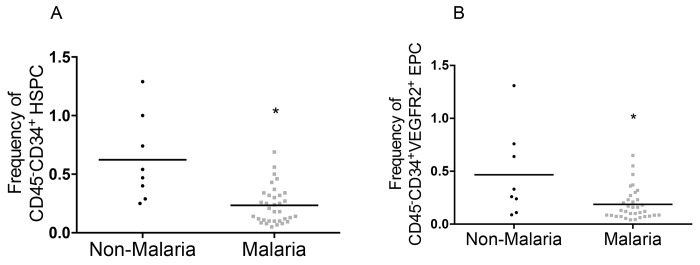
CD34+ cell populations decreased in malaria.(A) CD34+ hematopoietic stem and progenitor cell populations are significantly decreased in malaria patients. Median fluorescence intensity; 0.5 (IQR 0.3–0.9) in non-malaria, n = 8, vs. 0.2 (IQR 0.1–0.3) in malaria patients, n = 34, p = 0.0006. (B) Circulating EPC numbers (CD45-CD34+VEGFR2+) are decreased in malaria patients by 1.7-fold compared with non-malaria. Median fluorescence intensity; 0.3 (IQR 0.1–0.7) in non-malaria, n = 8 vs malaria 0.1(IQR 0.1–0.2), n = 34, p = 0.02. Data represented as median frequency and Interquartile Range (IQR). Mann-Whitney tests were used to calculate p-value.